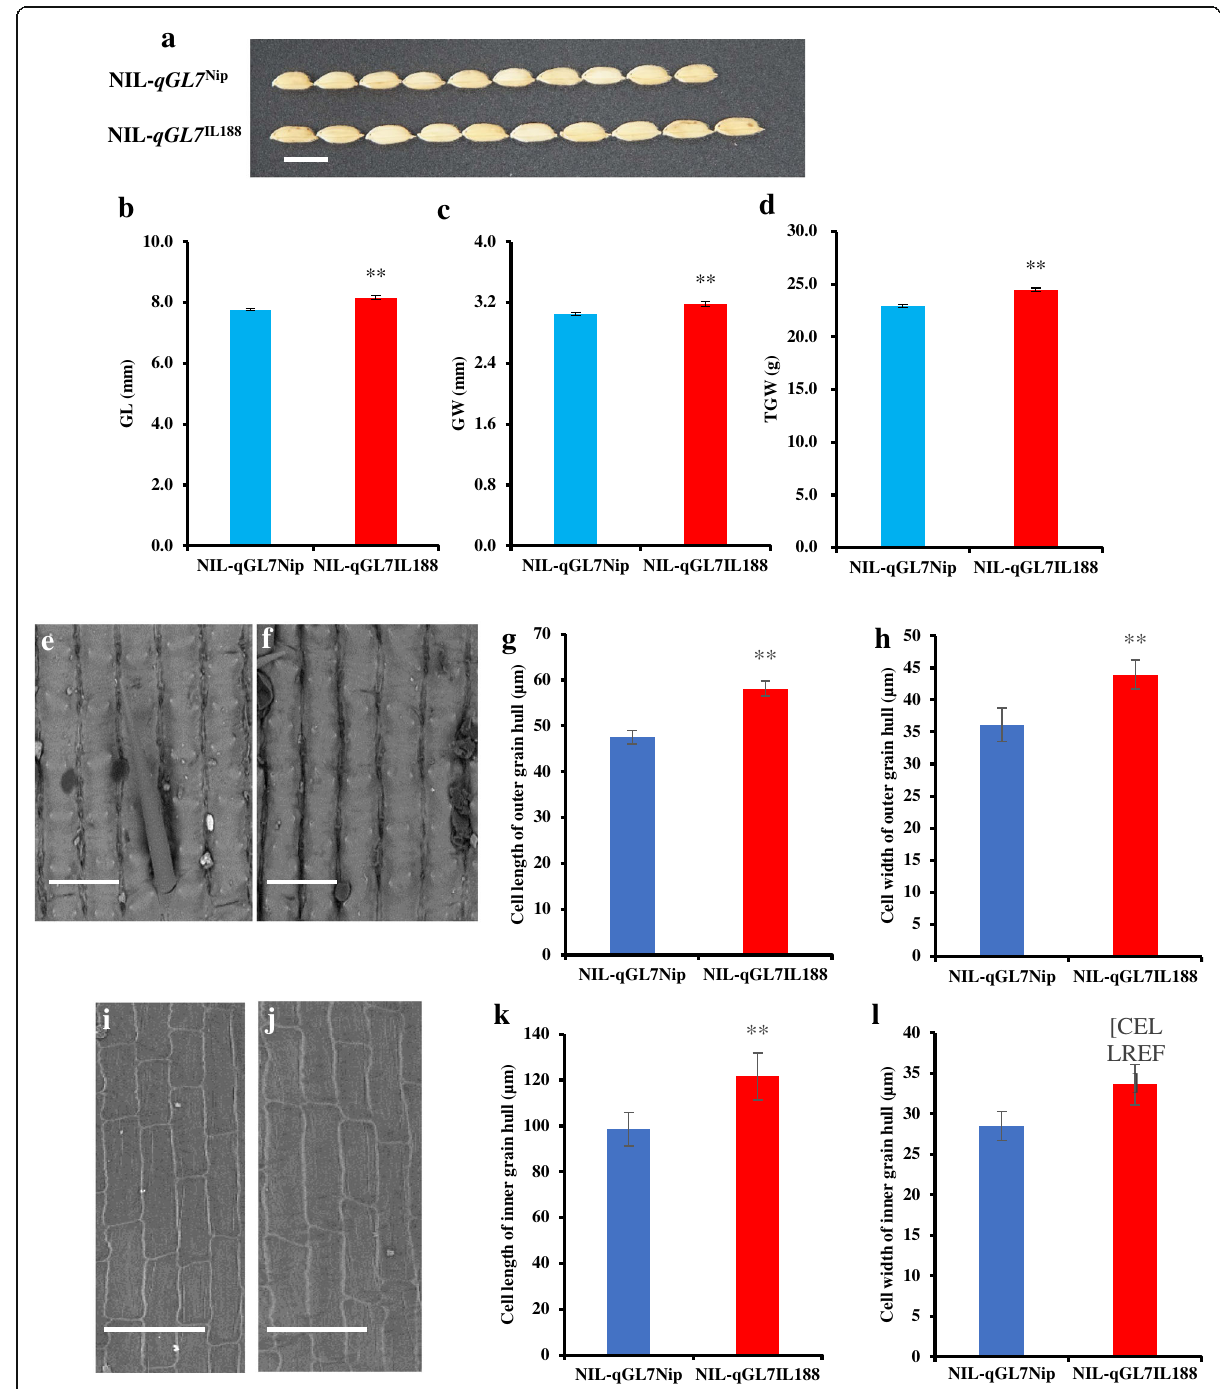
Fig. 5 Comparison of grain size and spikelets epidermal cells between NIL-qGL7Nip and NIL-qGL7IL188. a , Mature grains of NIL-qGL7Nip and NIL- qGL7IL188. Scale bar, 6 mm. b – d , Grain length (GL), grain width (GW), and 1000-grain weight (TGW) for NIL-qGL7Nip and NIL-qGL7IL188. Data are given as mean ± (n = 20). ** indicate significant difference at 0.01 level. e – f , Outer epidermal cells of grain hulls of NIL-qGL7Nip and NIL- qGL7IL188. Bars = 100 μ m. g – h , The average length and width of outer epidermal cells. (n = 10). i – j , Inner epidermal cells of grain hulls of NIL- qGL7Nip and NIL-qGL7IL188. Bars = 100 μ m. k – l , The average length and width of inner epidermal cells (n =